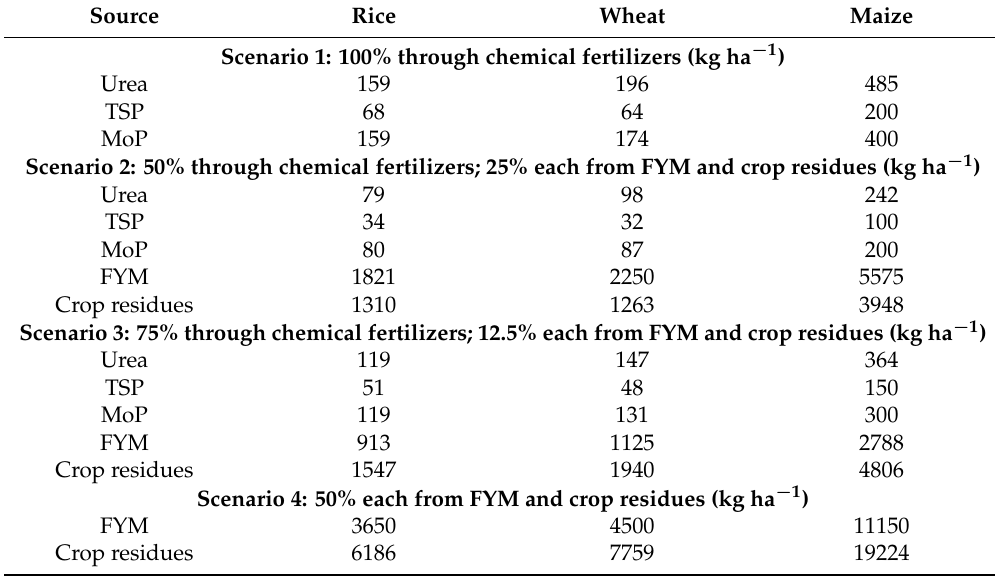
Table 3. Quantities of chemical fertilizers, farmyard manure (FYM) and crop residues required (kg ha − 1 ) to attain yield targets of rice, wheat and maize (5, 5 and 10 t ha − 1 , respectively) for various scenarios of nutrient application (adapted from Timsina, 2018, Agriculture & Forestry University, Nepal,